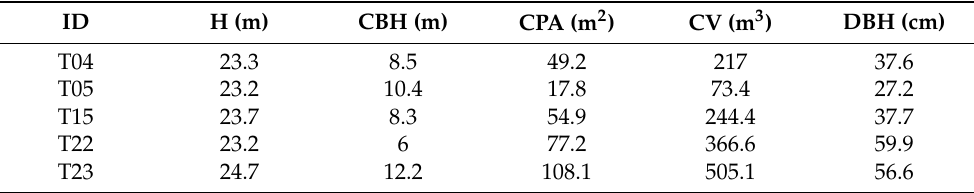
Table A1. Tree metrics of the five randomly selected